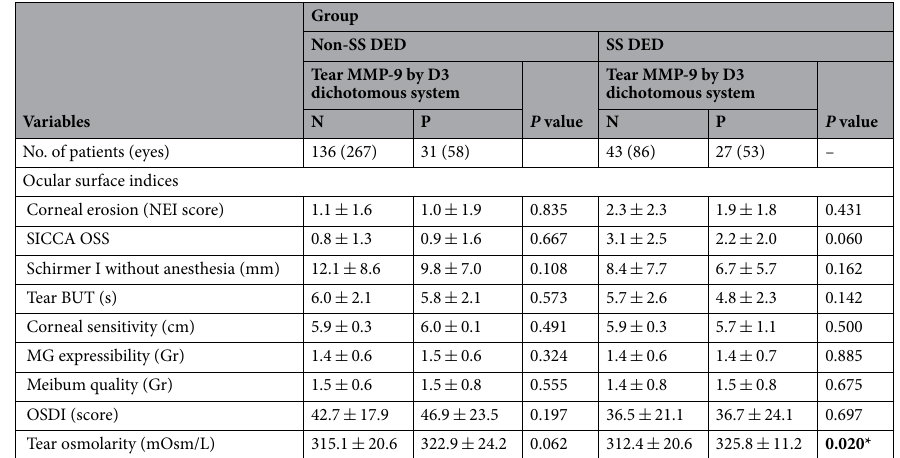
Table 4. Ocular surface indices according to D3 dichotomous system for tear matrix metalloproteinase 9 (MMP-9) expression in subjects with dry eye disease (DED) with and without primary Sjogren’s syndrome (pSS). * P < 0.05. N, negative. P, positive. Gr, grade. OSDI, ocular surface disease index. OSS, ocular staining score. BUT, break-up time. MG, meibomian gland. Significant are in value [bold].